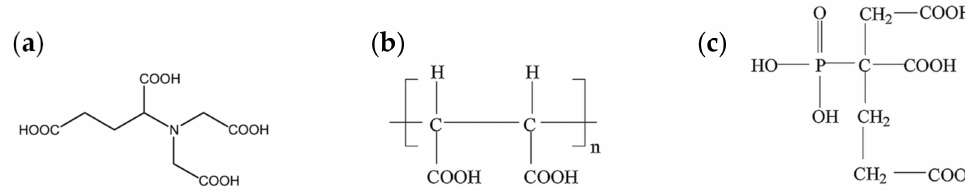
Figure 4. Structures of chemicals used for soil washing: ( a ) N,N -bis(carboxymethyl)- l -glutamic acid (GLDA); ( b ) hydrolytic polymaleic anhydride (HPMA); ( c ) 2-phosphonobutane-1,2,4-tricarboxylic acid